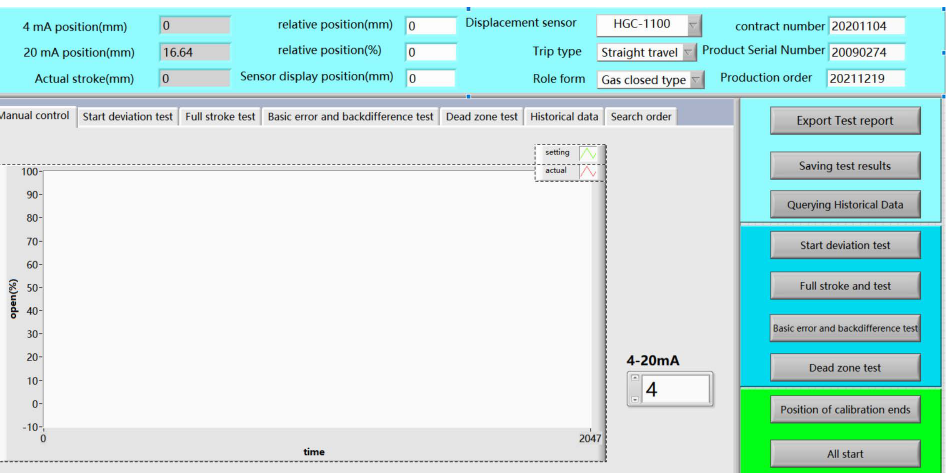
Figure 16. Control valve performance testing platform.